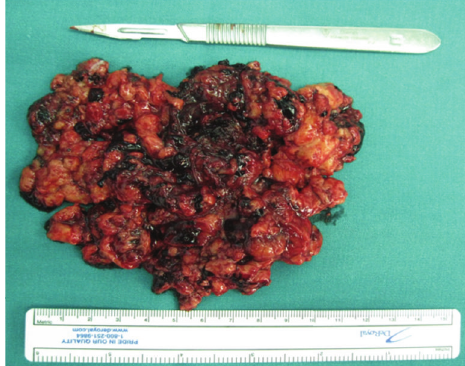
Figure 3: Macroscopic appearance of the ruptured